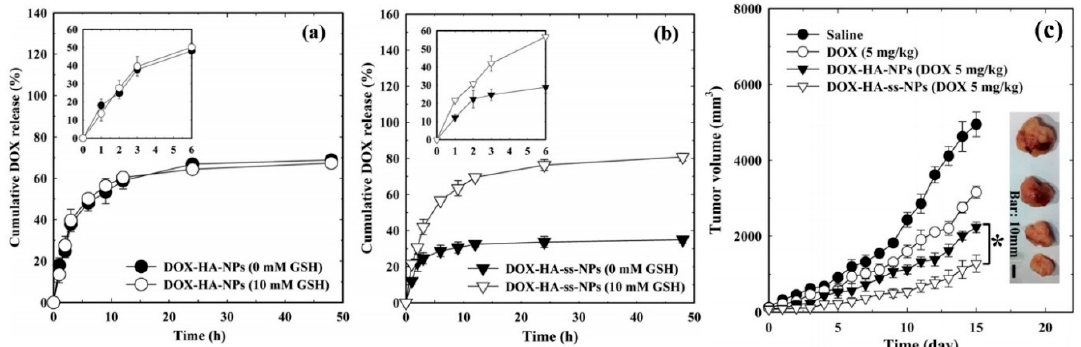
Figure 15. In vitro release behavior of DOX from HA nanoparticles in the presence and absence of GSH: ( a ) DOX-HA-NPs and ( b ) DOX-HA-ssNPs. Insets are magni fi ed drug release graphs (0 − 6 h). The error bars in the graph represent standard deviations ( n = 3). ( c ) Tumor growth of SCC7 cancer xenografts treated with saline, free DOX, DOX-HA-NPs, and DOX-HA-ss-NPs at a DOX dose of 5 mg/kg. Insets are representative tumor images excised 16 days post-treatment. Error bars in the graph represent the standard deviation for five animals per group. Asterisks (*) denote statistically significant differences ( p < 0.05) as determined by one-way ANOVA. From [105].